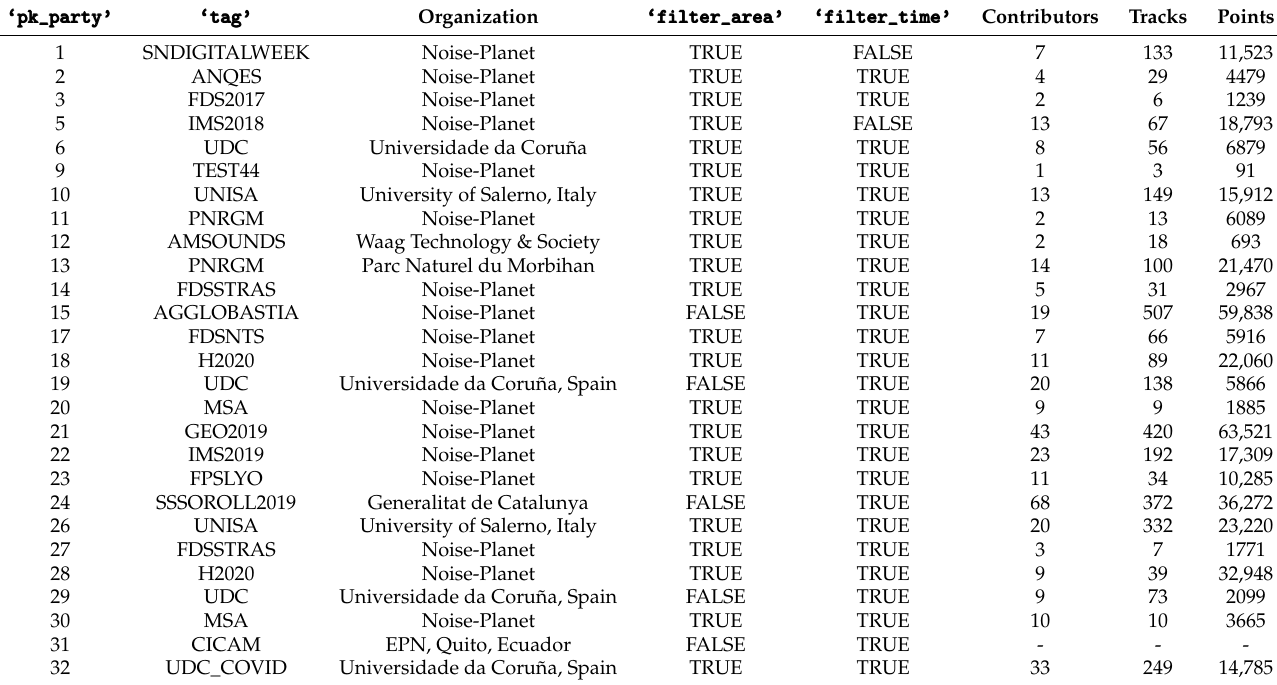
Table 17. List of NoiseCapture Parties. More information are located in the ‘noisecapture_party’ table of the database. The number of contributors, as well as the total of collected tracks and points are given. The organization in charge of the NoiseCapture Party is also mentioned (Noise-Planet is the organization in charge of the development of NoiseCapture application). While the CICAM NoiseCapture Party has been planned, it was canceled due to the pandemic situation (i.e., there are no corresponding